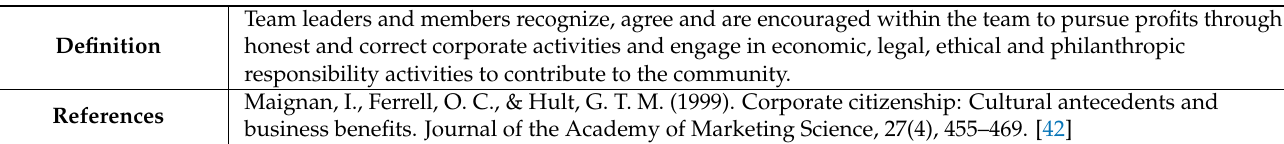
Table A1. Team’s CSR promotion